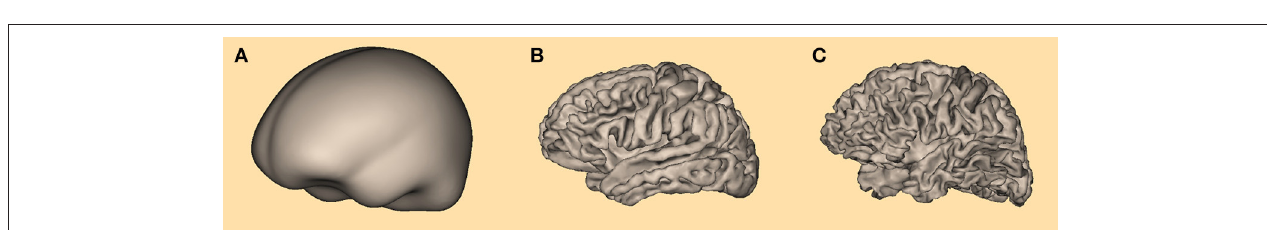
FIGURE 5 | Three different cortical meshes were used for determining the optimal value for σ : (A) the most simple form with 750 nodes, (B) averaged cortex form with 3,709 nodes, and (C) individual cortex form with 3,973 nodes.